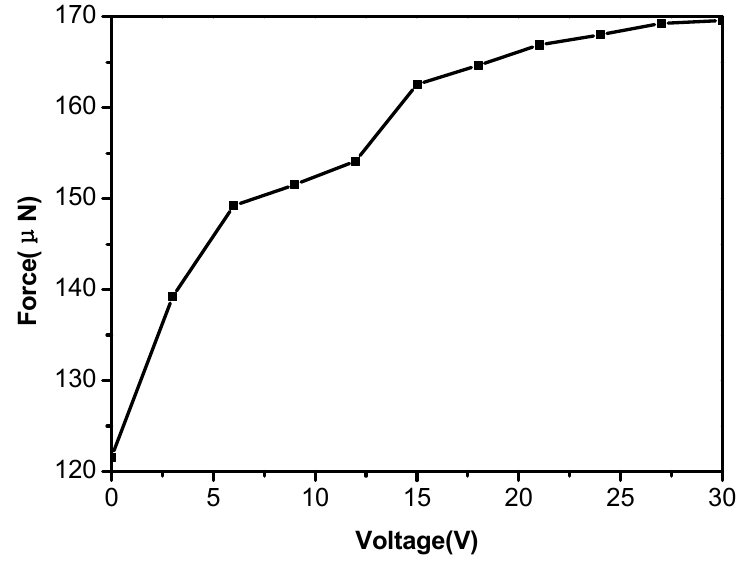
Figure 9. The adhesion force of the conductive polymer porous film at different